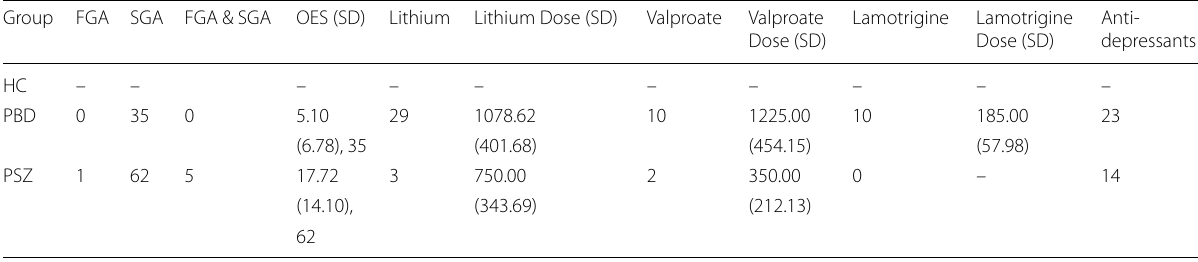
Number of patients receiving the different medication classes at time of study. FGA Olanzapine equivalence scores (OES) calculated according to Gardener et al. (2010), reported in mean (SD), and n of patients. Lithium, valproate and lamotrigine doses reported as n of patients and mean daily mg value (SD). Antidepressants reported as n of patients receiving this type of